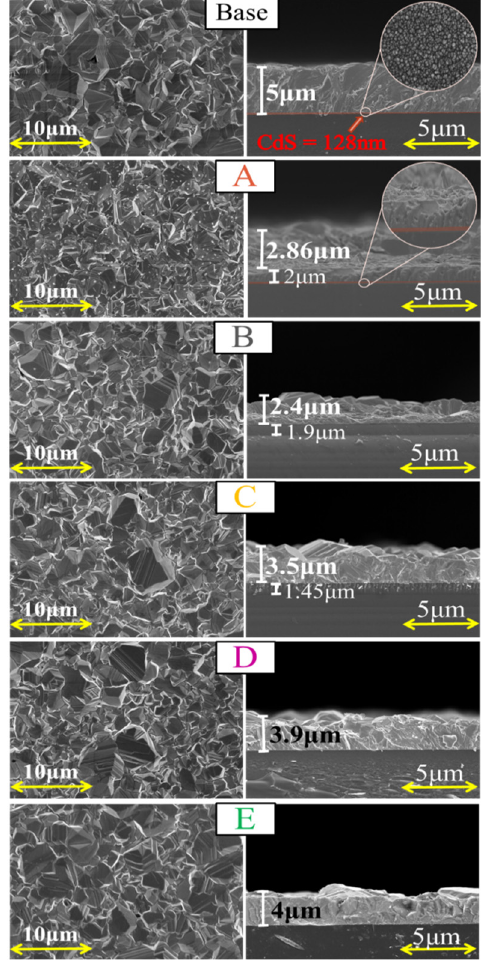
Figure 4. Surface morphology, top view (left figures) and cross-section views (right figures) of the base and CdCl 2 treated CdTe thin films obtained by FESEM.